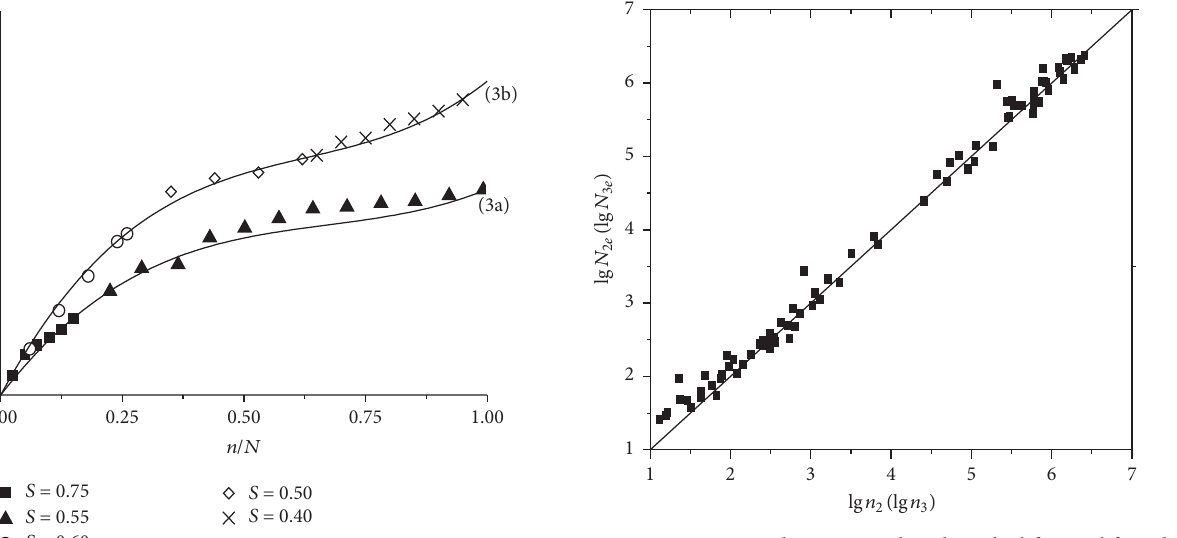
Figure 7: Comparison between predicted residual fatigue life and observed ones.